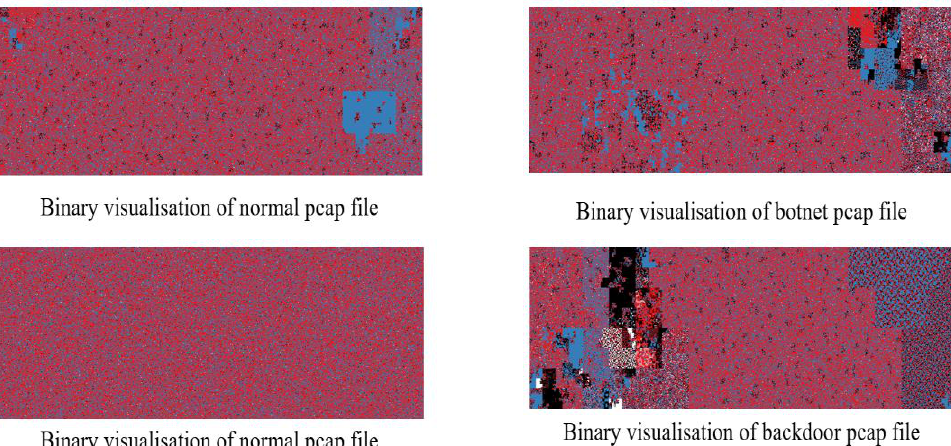
Figure 3 . Binvis 2D RRB-images of normal and malware pcap files . Figure 3. Binvis 2D RRB-images of normal and malware pcap